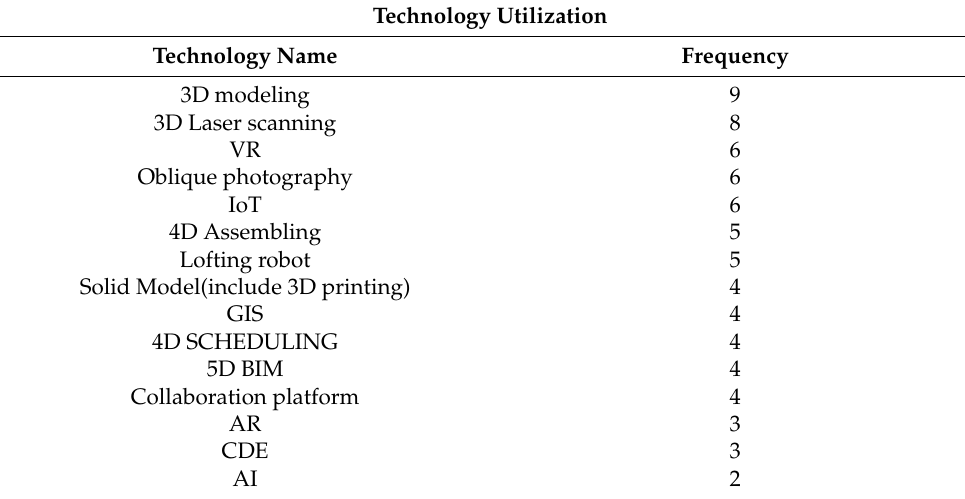
Table 11. Technology